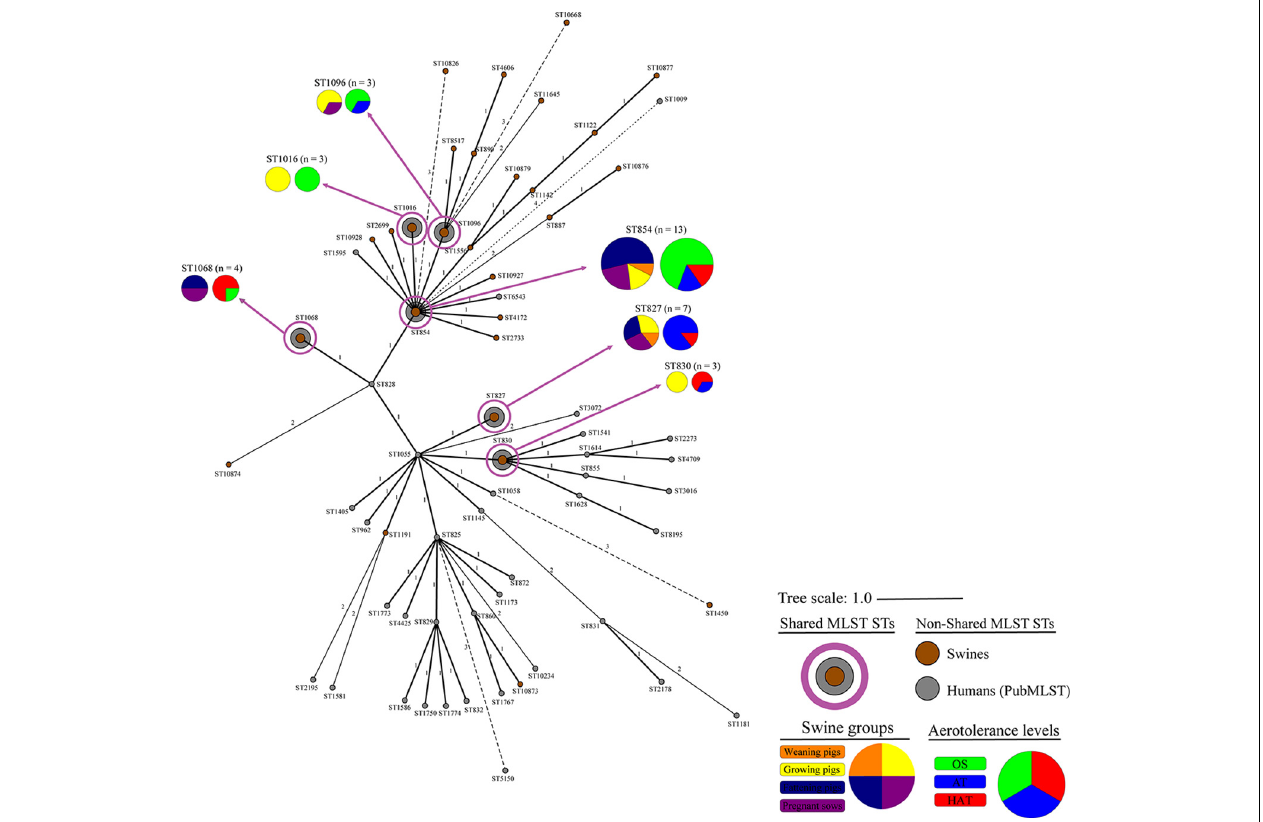
FIGURE 3 | Genetic relatedness of swine-derived Campylobacter coli isolates in this study with human C. coli isolates registered in the PubMLST. Cluster analysis of C. coli isolates from swine and humans was conducted using the MST method, based on the allelic profiles of the MLST housekeeping genes. Colors indicate the sources (brown, swine from this study; and gray, humans from PubMLST), the swine groups (orange, weaning pigs; yellow, growing pigs; navy, fattening pigs; and purple, pregnant sows), and aerotolerance levels of C. coli isolates (green, oxygen-sensitive, OS; blue, aerotolerant, AT; and red, hyper-aerotolerant, HAT). The numbers on the branches present the difference degree in allelic profiles for housekeeping